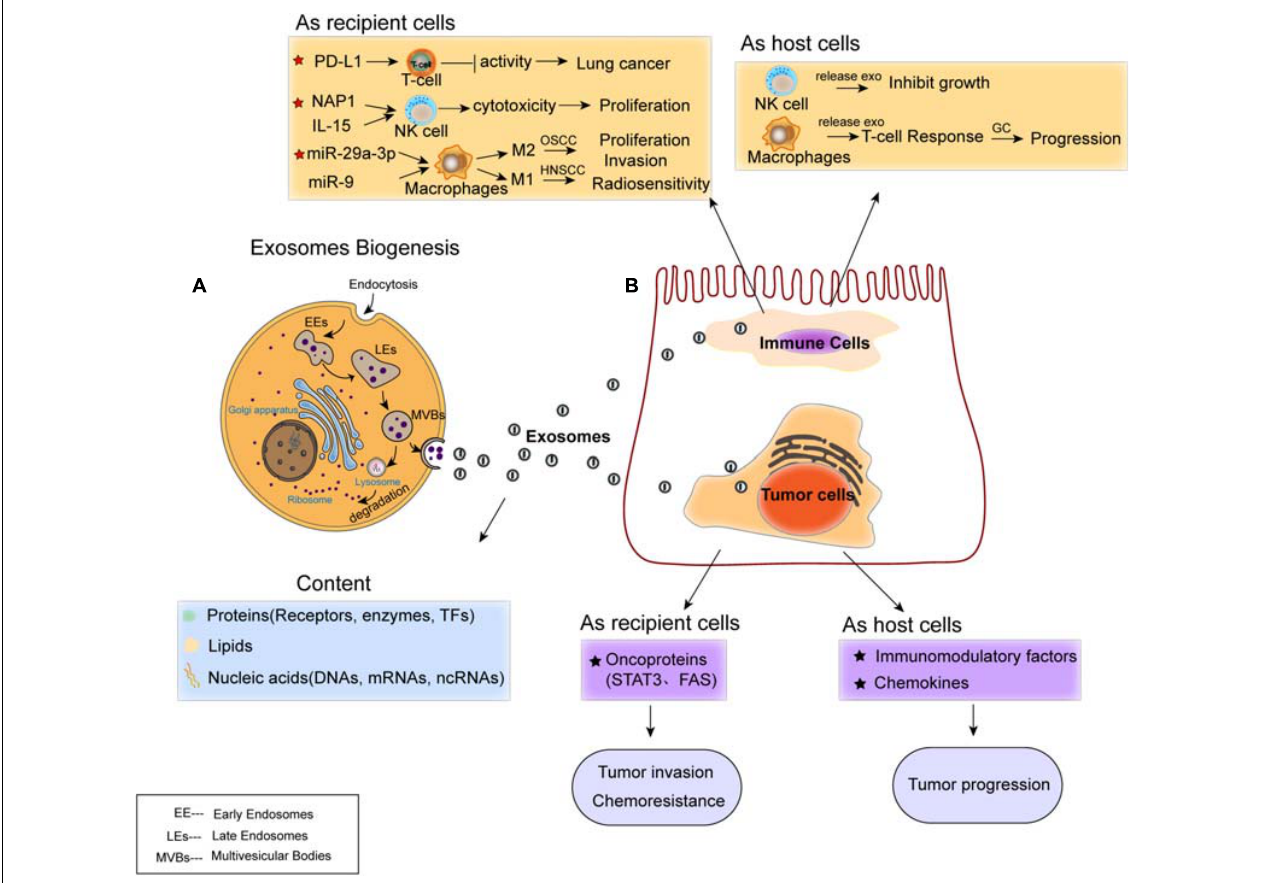
FIGURE 2 | Exosomes mediate cell–cell communication between cancer cells and immune cells. (A) Biogenesis and contents of exosomes. The content of exosomes could be multiple proteins, lipids, and nucleic acids. (B) Regulation of exosomes on cancer cells and immune cells. Exosomal cargoes such as microRNAs (miRNAs) and proteins, which are derived from both immune cells (T-cell, NK-cell, and macrophages) and diverse types of cancer cells, can be transferred to recipient cells, thereby modulating the tumor proliferation, invasion, metastasis, and drug resistance. Both immune cells and cancer cells act as host cells and recipient